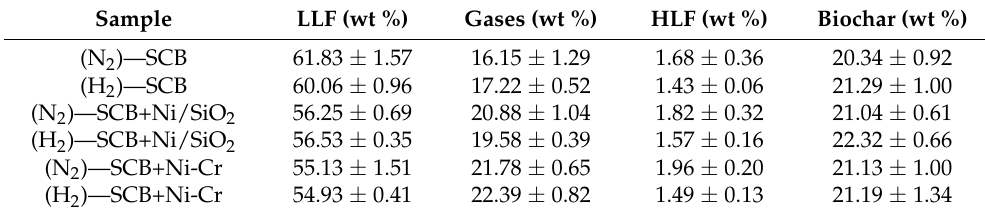
Table 1. Non-catalytic and catalytic pyrolysis and hydropyrolysis product